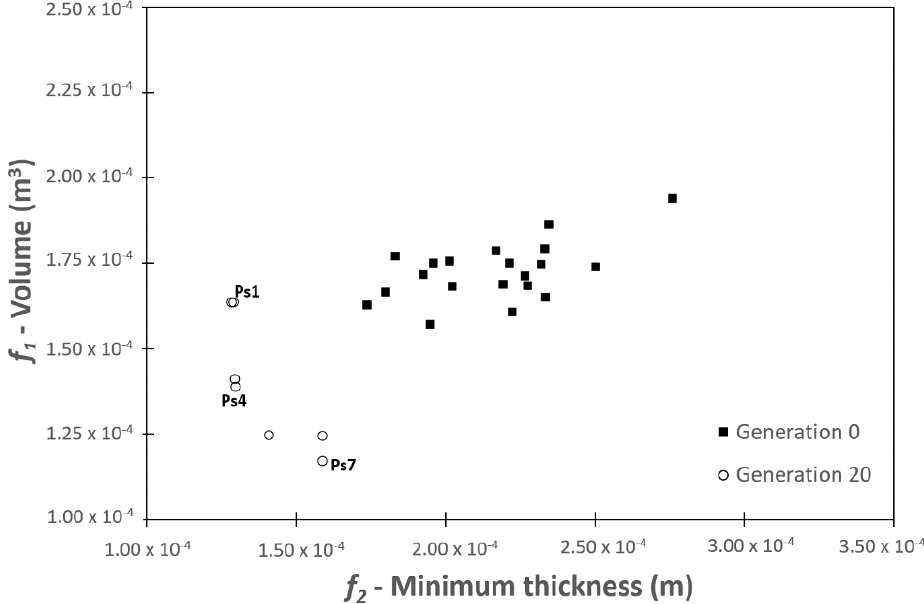
Figure 10. Initial population and non-dominated solutions of final population (20th generation).